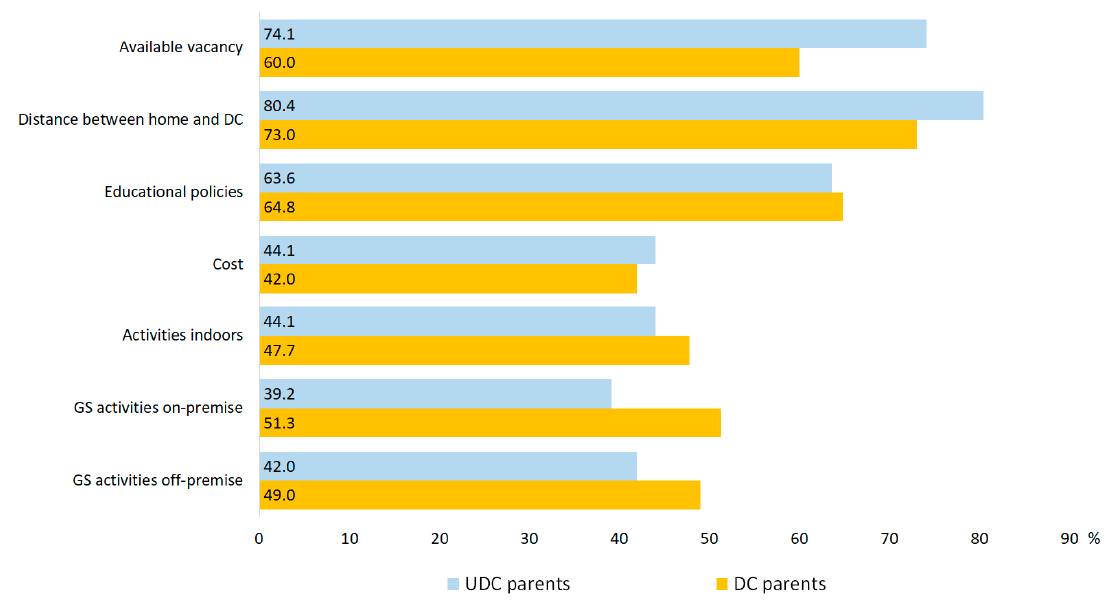
Figure 5. Parents’ reasons for choosing daycare centers. Percentage represents combined answers “important” and “very important”.